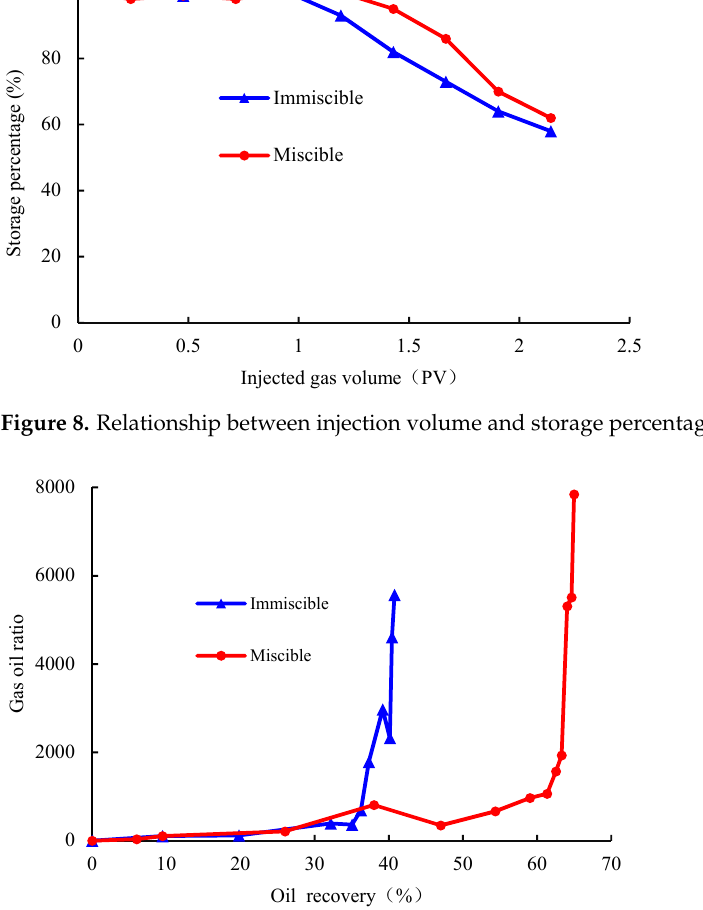
Figure 8. relationship between injection volume and storage percentage. Figure 9. relationship between gas-oil ratio and recovery degree. Figure 9. Relationship between gas-oil ratio and recovery